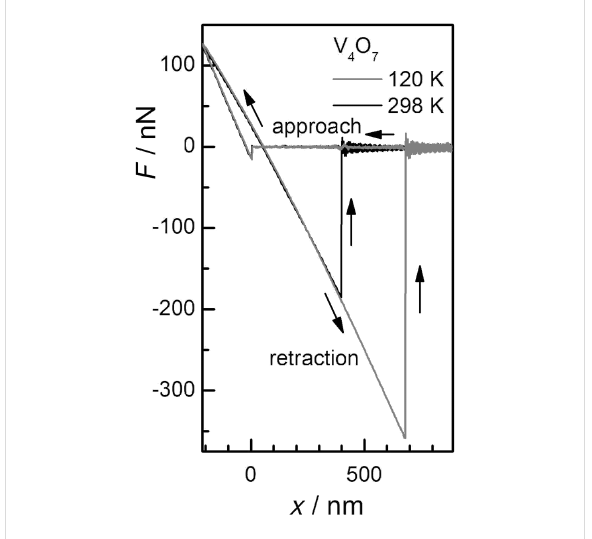
Figure 3: Typical force ( F ) vs distance ( x ) curves obtained on V 4 O 7 for single measurements of a spherical Ti tip (diameter 7.2 µm) against the flat crystal plane at 120 K and 298 K. The curves show the force interaction during approach and retraction of the tip from the surface. The adhesion force corresponds to the pull-off force between the tip and sample